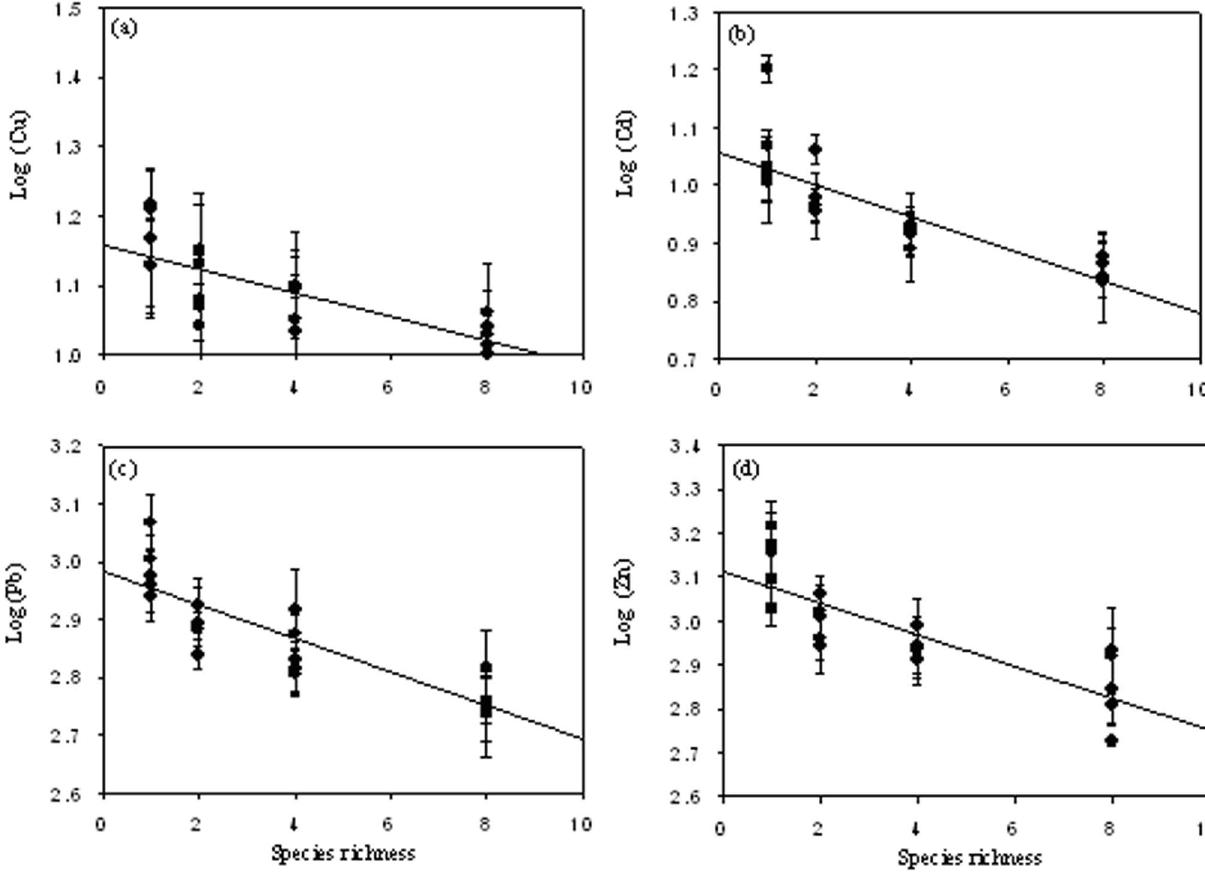
Figure 1. The dependence of soil trace metal concentration on the actual species richness (SR) in the natural plant communities. (a) Fitted line: Log (Cu)=1.180 2 0.688 SR, n =25, P =0.001. (b) Fitted line: Log (Cd)=1.058 2 0.832 SR, n =25, P , 0.001. (c) Fitted line: Log (Pb)=2.981 2 0.862 SR, n =25, P , 0.001. (d) Fitted line: Log (Zn)=3.115 2 0.815 SR, n =25, P , 0.001.